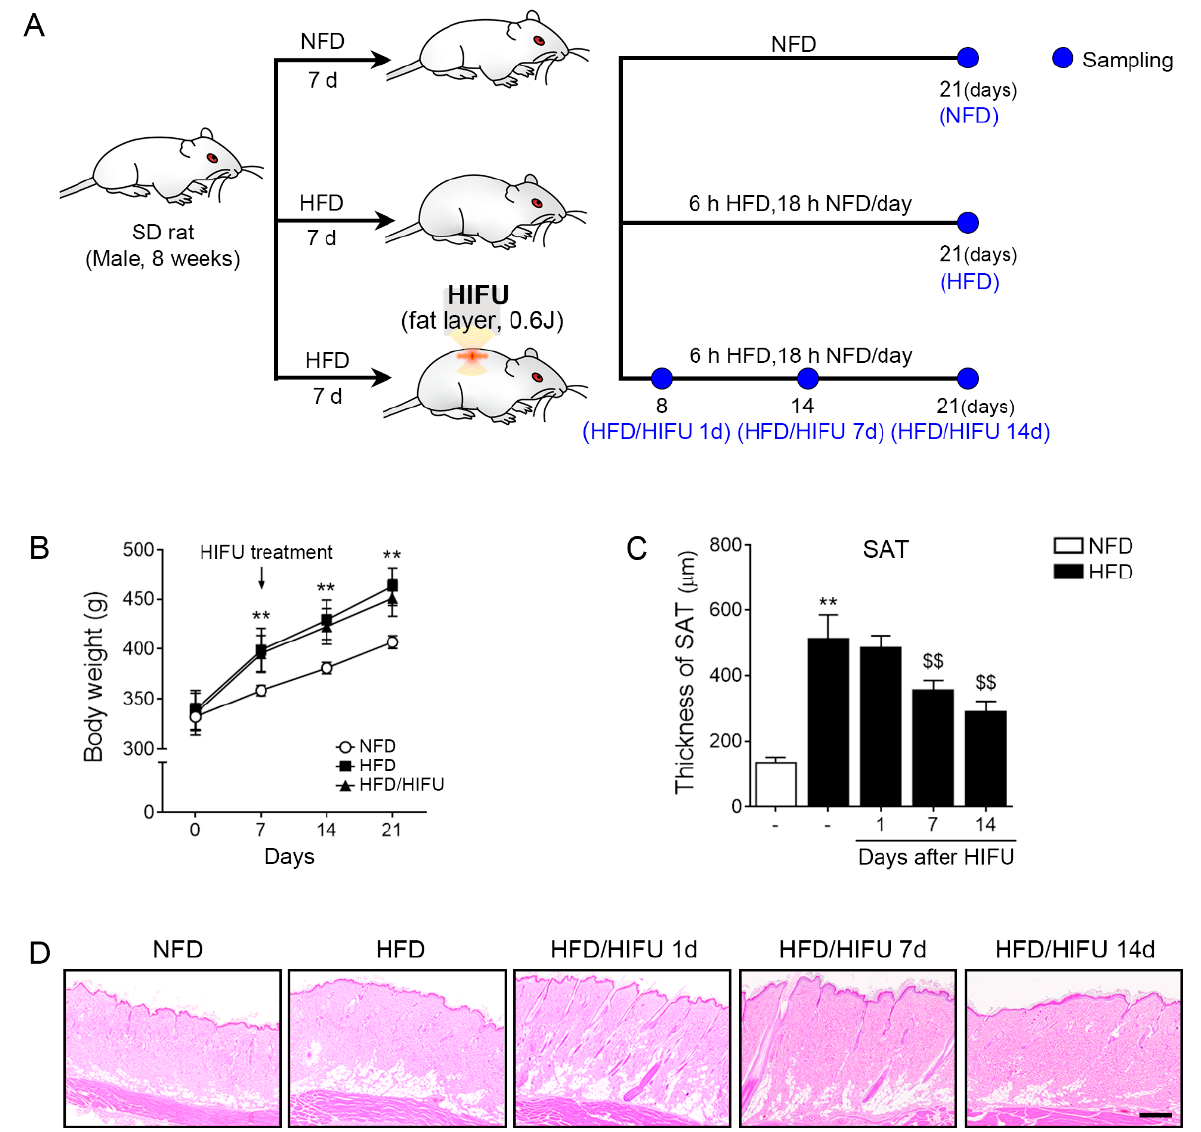
Figure 1. Regulation of SAT thickness by HIFU treatment. ( A ) Schematic diagram of the animal study. ( B ) Body weight changes were analyzed. ( C , D ) The thickness of SAT was analyzed by hematoxylin and eosin staining. The thickness of SAT was decreased by HIFU treatment. The data are presented as the mean ± standard deviation; **, p < 0.01 HFD vs. NFD; $$, p < 0.01 vs. HFD (Mann–Whitney U test). d, days; h, hours; HFD, high-fat diet; HIFU, high-intensity focused ultrasound; NFD, normal-fat diet; SAT, subcutaneous adipose tissue; SD, Sprague–Dawley.